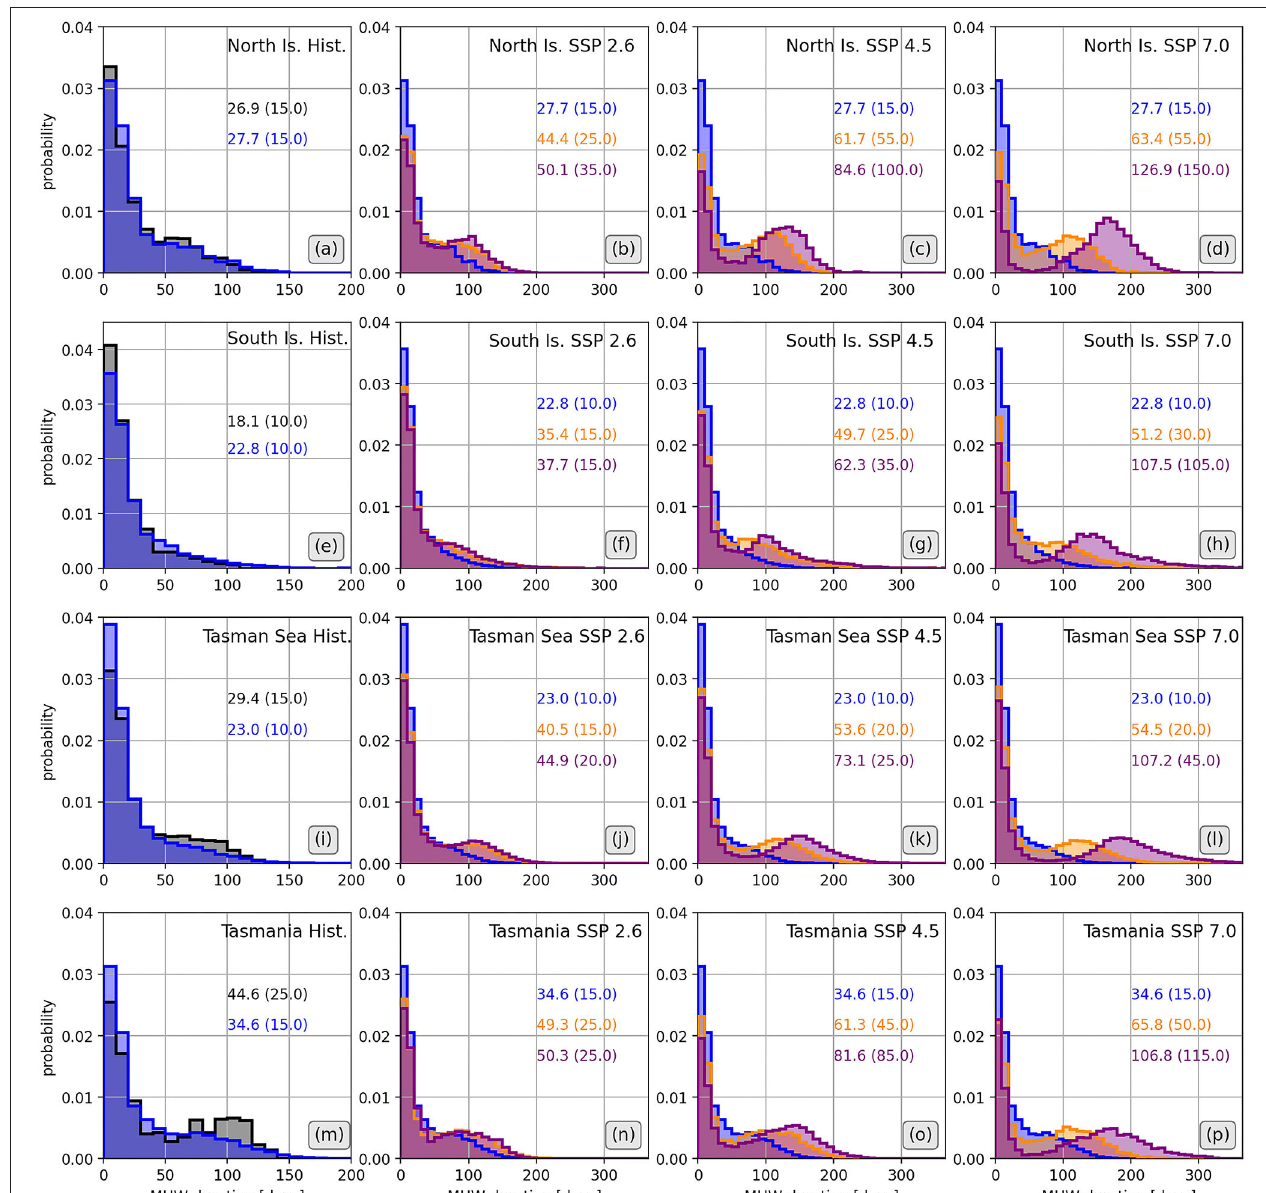
FIGURE 5 | Evolution of MHW duration. Histograms show the probability distribution for certain regions, and periods for the historical simulations and future projections. (a–d) coastal region around the North Island. (e–h) coastal region around the South Island. (i–l) over the Tasman Sea and (m–p) around Tasmania. Regions are shown in Figures 1 , 2 and Supplementary Figure S4 . NOAA OI-SST is represented by black, while NZESM is represented by blue for the historical period 1995–2014. For the future scenarios the orange and purple distribution indicates 2040–2059 and 2080–2099, respectively. The color coded numbers in each panel represent the mean (median, in parenthesis) MHW duration for each distribution. The MHW duration bins are 10 days wide and the area under curve integrates to 1.